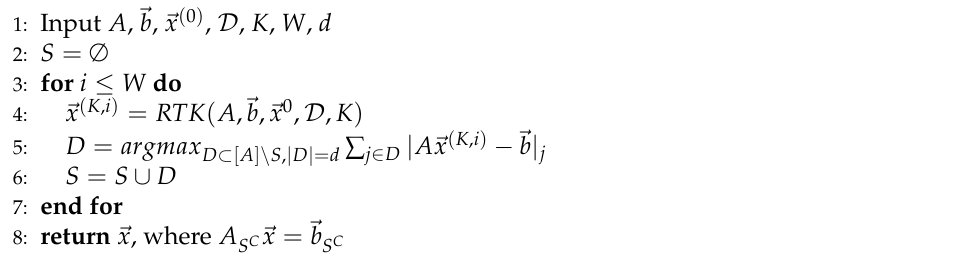
Algorithm 3 Multiple Round Randomized Tree Kaczmarz (MRRTKUS) algorithm